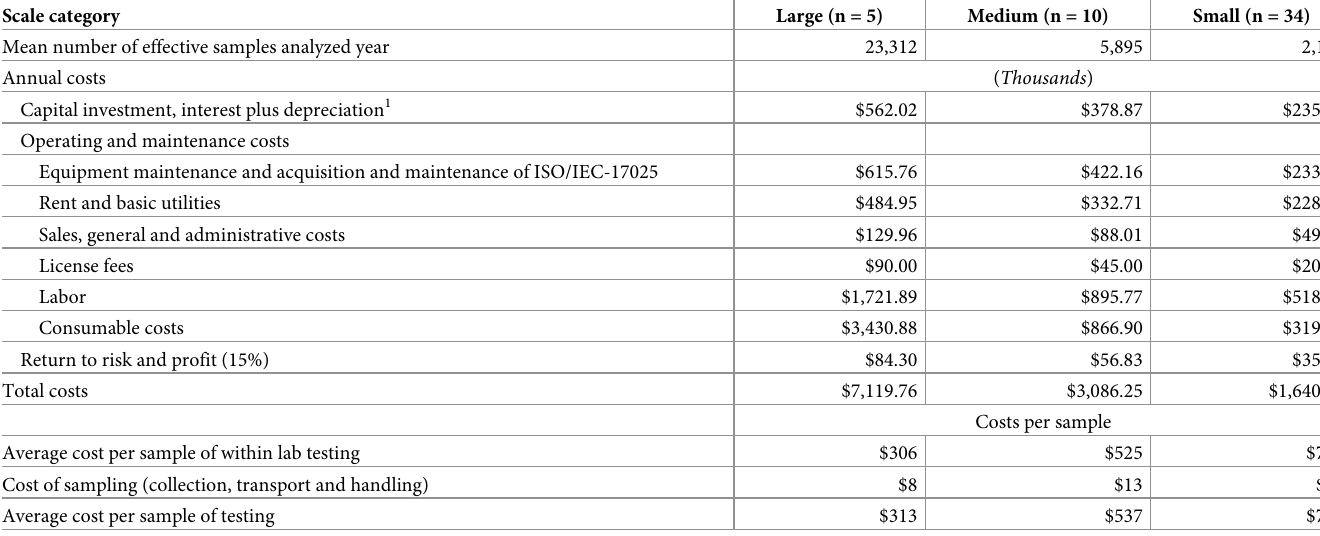
Table 6. Testing capacity, itemized annual costs, and testing cost per sample by laboratory